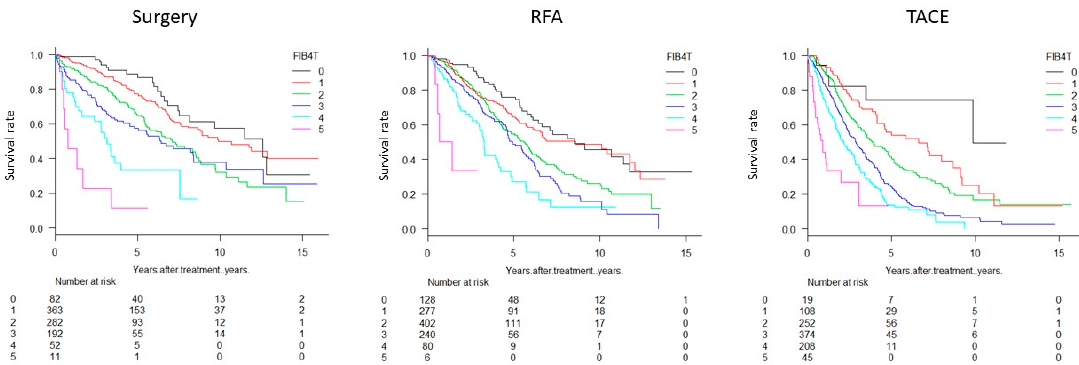
Figure 3. Survival curves stratified with FIB4-T for different treatments. Stratification was possible regardless of treatment type (surgery, p < 0.0001; RFA, p < 0.0001; TACE, p < 0.0001). Abbreviations: RFA, radiofrequency ablation; TACE, transcatheter arterial chemoembolization.